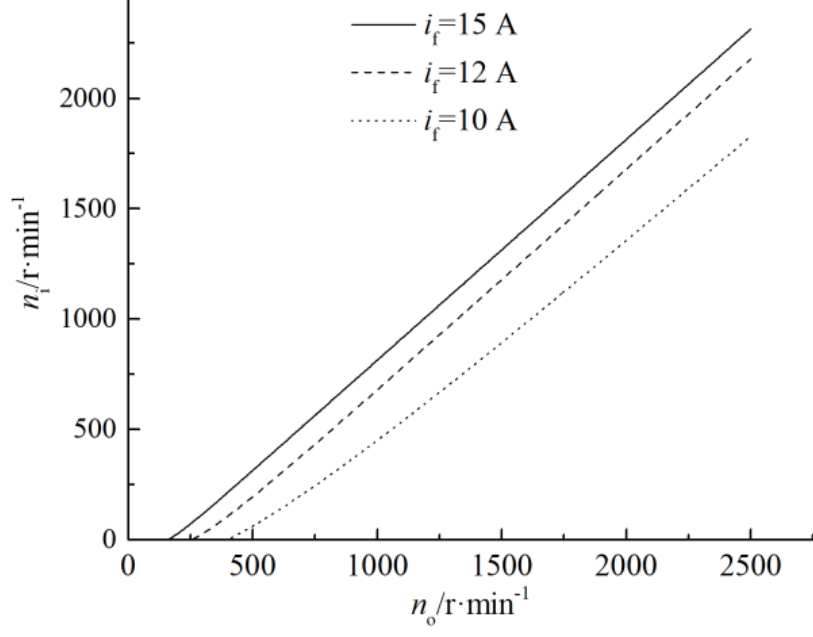
Figure 8. Curves of the input-output speeds.